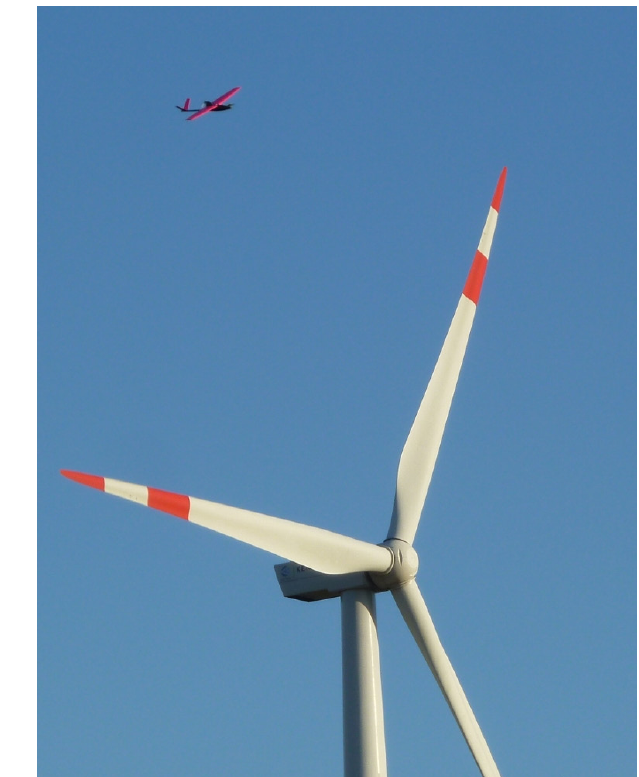
Figure 1. Research RPA MASC in front of a Kenersys K110 WEC (picture taken by Joe Smith, University of Tübingen).